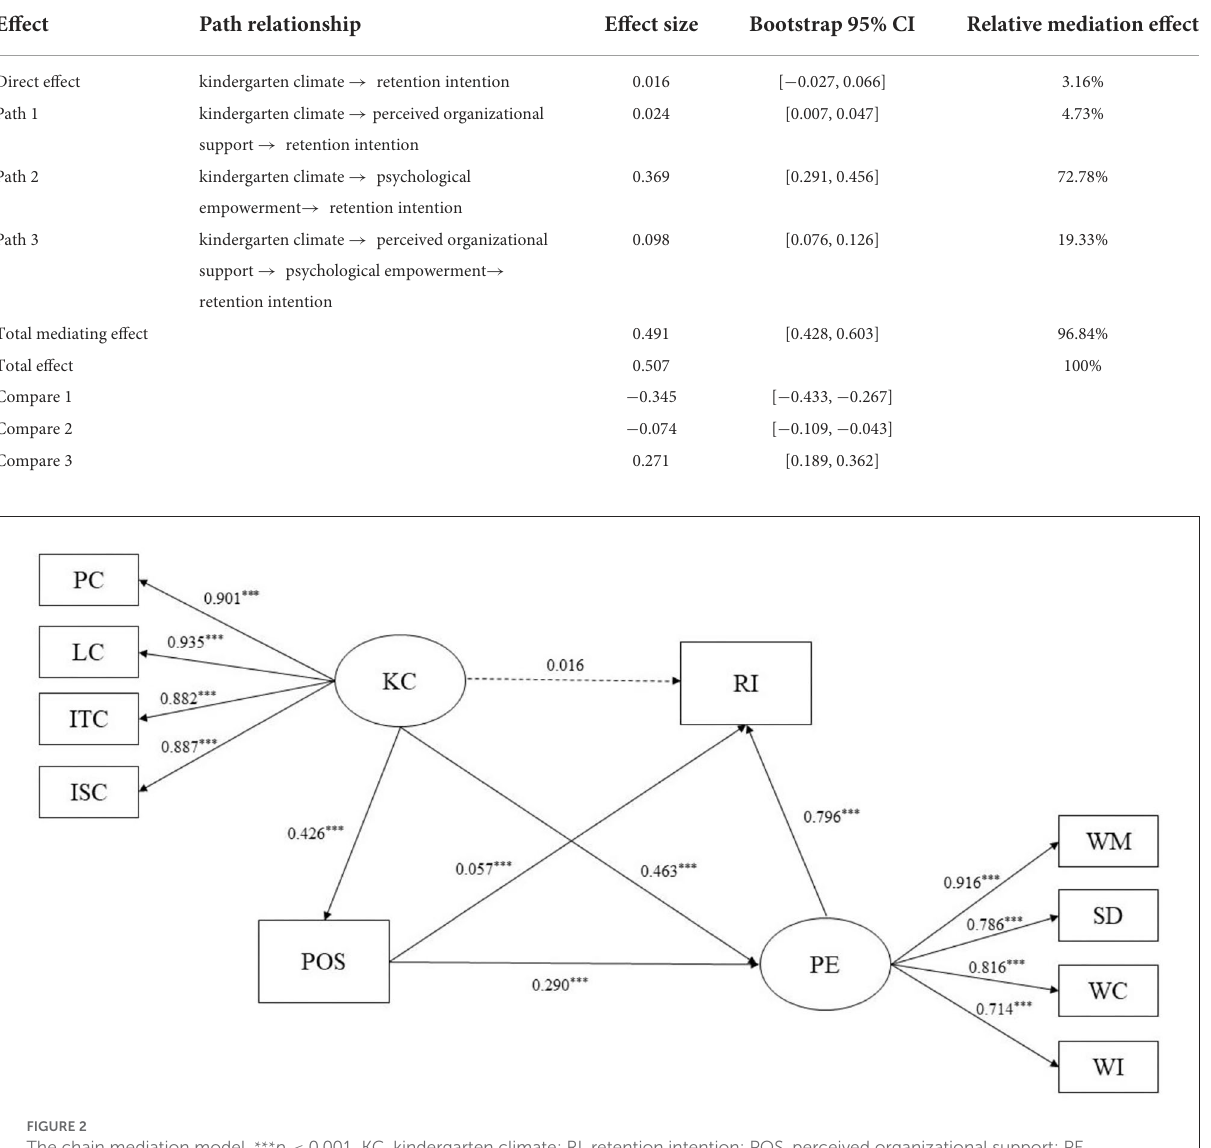
TABLE 3 Perceived organizational support and psychological empowerment in the mediating effect analysis.